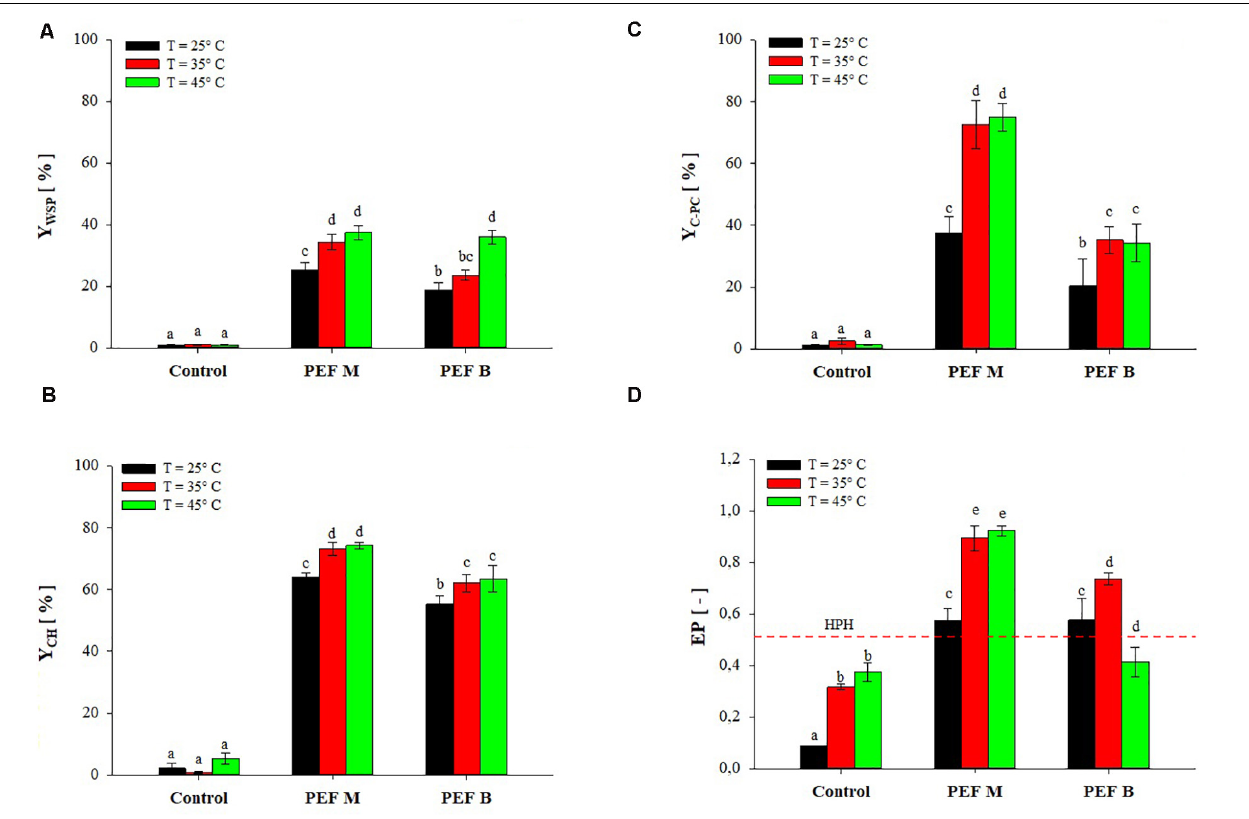
FIGURE 5 | Extraction yield of water-soluble proteins (A) , carbohydrates (B) , and C-PC (C) , and protein purity (D) of extracts obtained from untreated (Control) and PEF-treated ( E = 20 kV/cm; W T = 100 kJ/kg susp ) A. platensis suspensions with either monopolar (M) or bipolar (B) pulses (10 µ s pulse delay time), as a function of the inlet processing temperature The yields were calculated considering 100% extraction yield upon the HPH treatment ( P = 150 MPa, n P = 3). Different letters above the bars indicate significant differences among the mean values ( p ≤